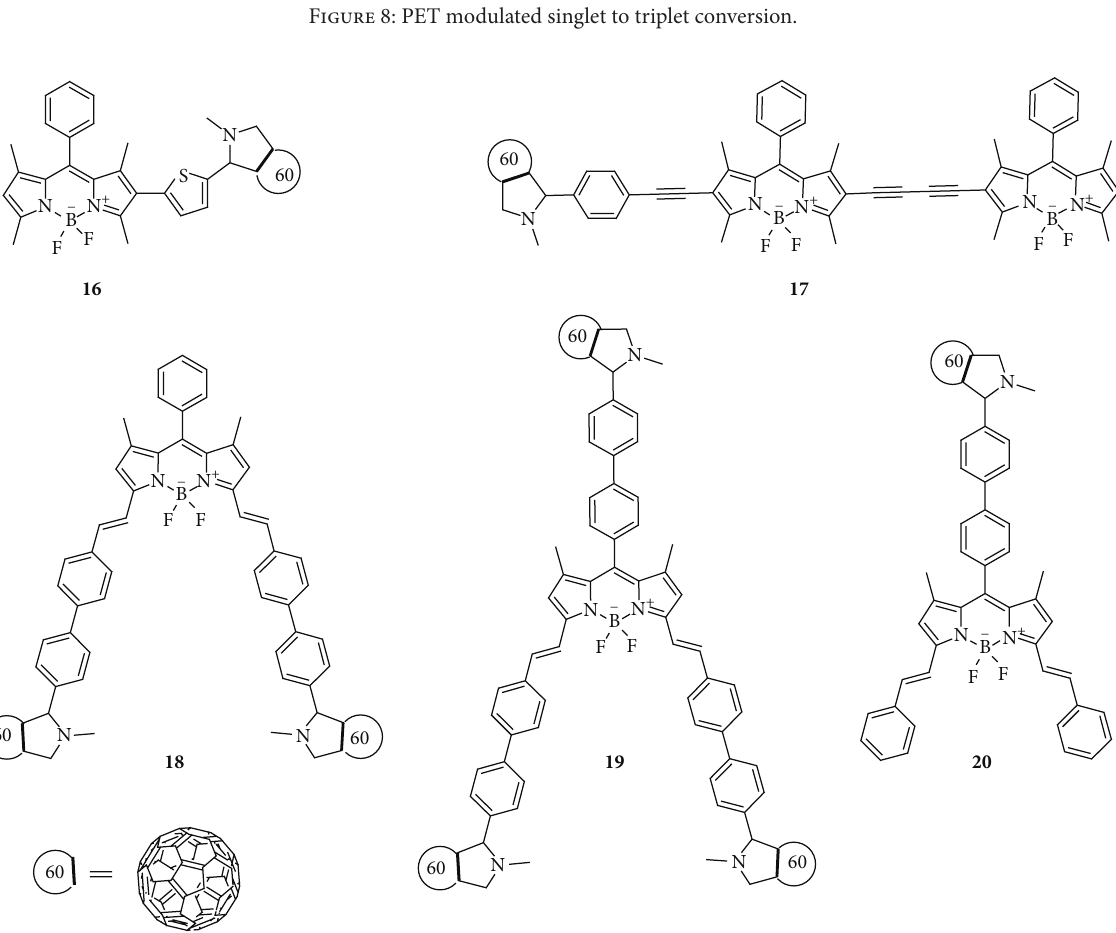
Figure 9: Structures of BODIPY dyads bearing C 60